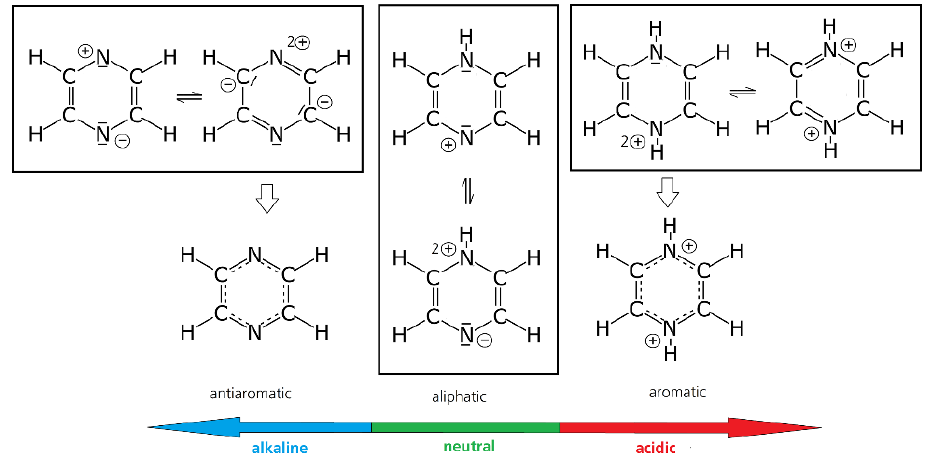
Figure 2. Example of the influence of pH on chemical stability. Tautomeric structures of a non- protonated (alkaline environment), single protonated (neutral environment), and double protonated (acidic environment) pyrazine ring and the related changes of the anti ‐ aromatic, aliphatic, and aromatic state [27] (it should be mentioned that the anti ‐ aromatic nature of unprotonated pyrazines is still under discussion [28]).